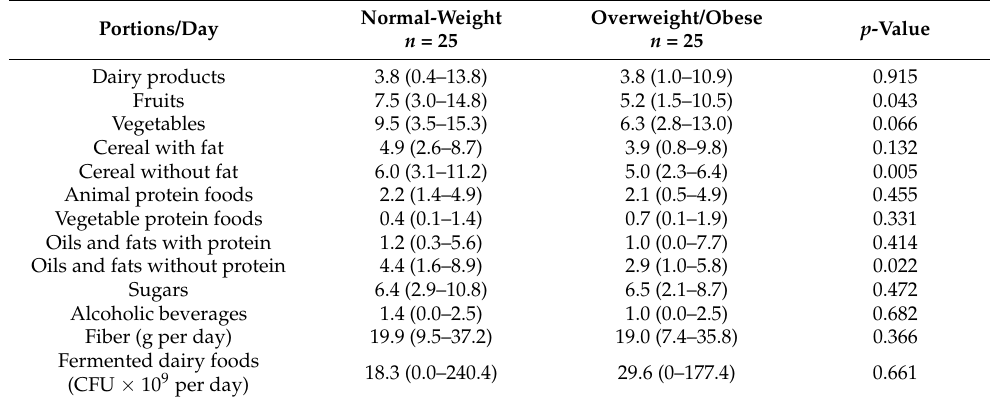
Table 3. Consumption of food portions of the study groups according to the Food Guide